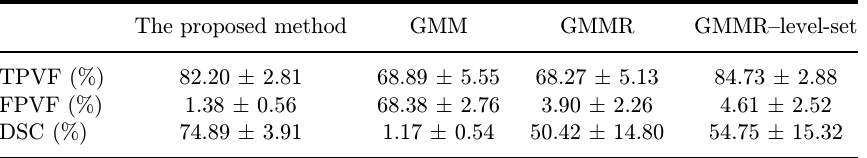
Fig. 9. 3D visualization of retinal °uid segmentation in the whole SD-OCT volume. Table 1. Mean (cid:6) standard deviation of TPVF, FPVF and DSC for segmentation by our proposed method, GMM, GMMR, GMMR –